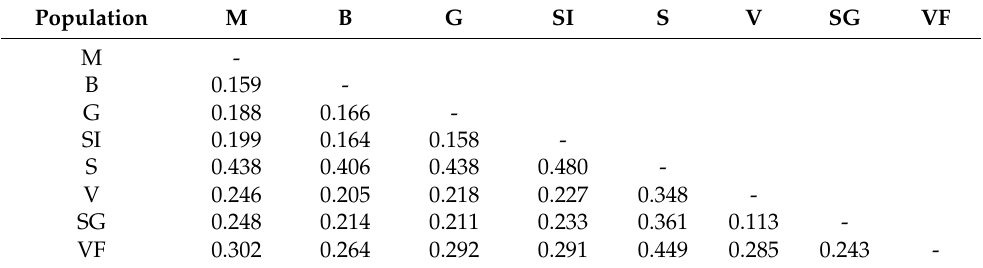
Table 5. Pairwise population PhiPT values based on 999 permutations from AMOVA analysis among Astragalus exscapus subsp. transsilvanicus populations (all PhiPT values were significantly greater than 0, p < 0.0001).